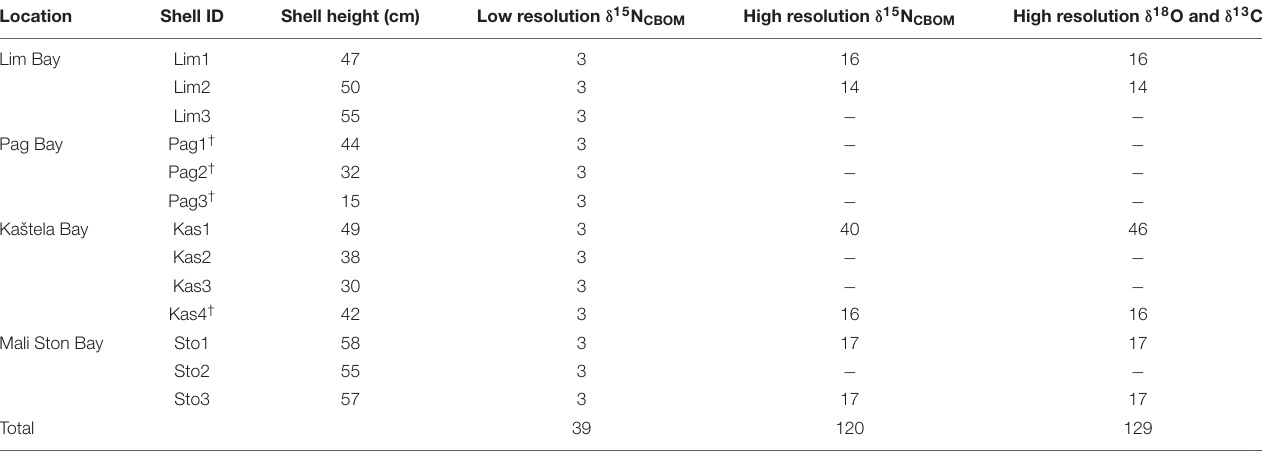
TABLE 1 | Overview of Pinna nobilis specimens and number of samples per shell used in this study. Location Shell ID Shell height